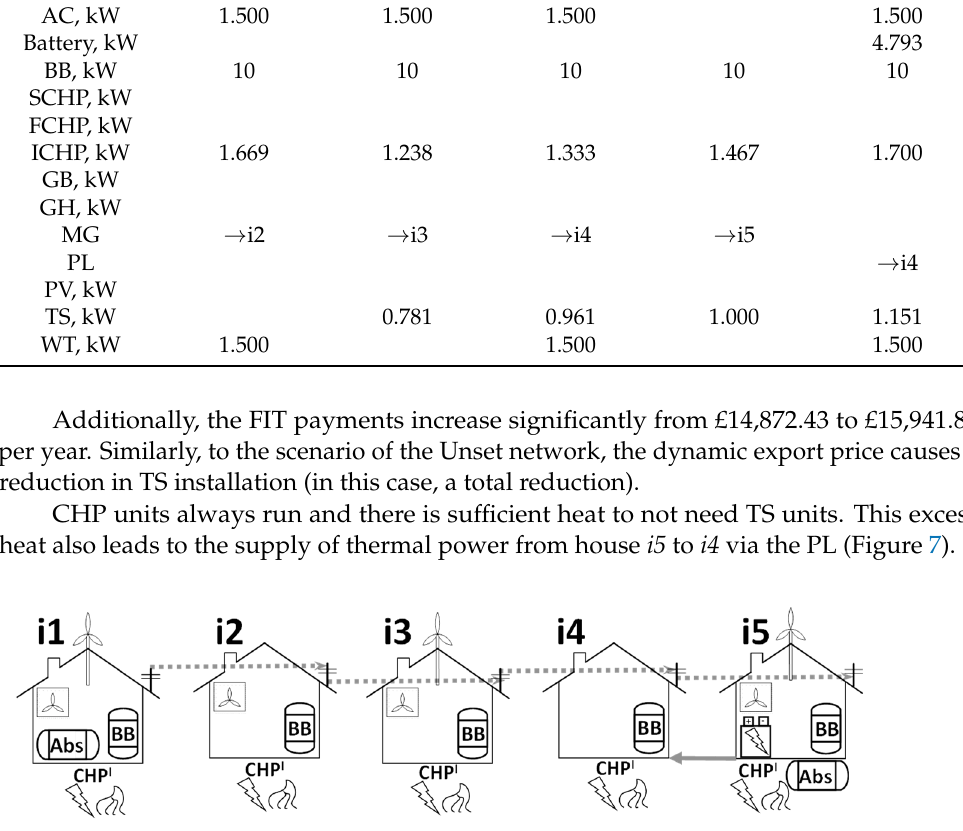
Figure 7. Design of the grid connected battery network with dynamic export pricing.